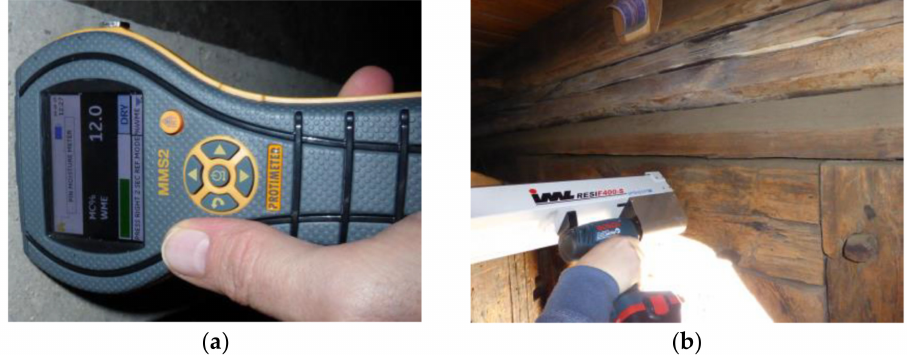
Figure 21. Wood testing: ( a ) by moisture measure meter and ( b ) by resistograph.